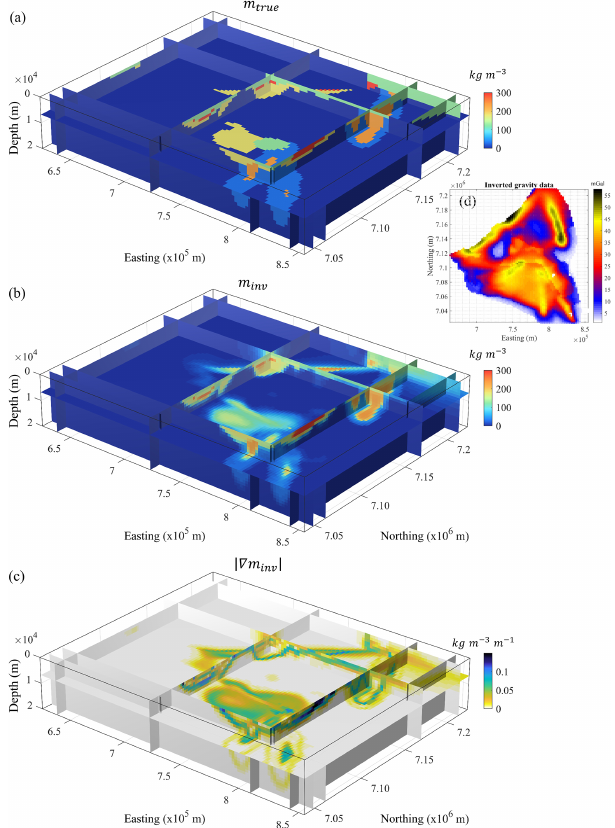
Figure 5. True density contrast model for calculation of synthetic geophysical data (a) , inverted model obtained from geophysical in- version of synthetic geophysical data (b) , corresponding spatial gra- dient of density contrast (c) and synthetic geophysical data (d)